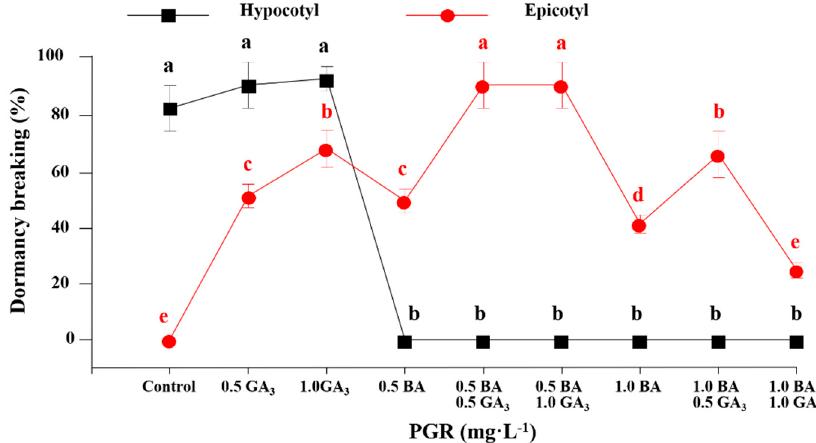
Figure 2. The percentage of epicotyl dormancy breaking a ff ected by the BA and GA 3 concentration after 8 weeks of culture. The PGR concentration is expressed in mg · L − 1 . The MS medium without any Figure 2 . The percentage of epicotyl dormancy breaking affected by the BA and GA 3 concentration PGRs was used as the control. Di ff erent letters indicate separation among treatments by Duncan’s after 8 weeks of culture. The PGR concentration is expressed in mg·L − 1 . The MS medium without any multiple range test at a 5% PGRs was used as the control. Different letters indicate separation among treatments by Duncan’s multiple range test at a 5% level.